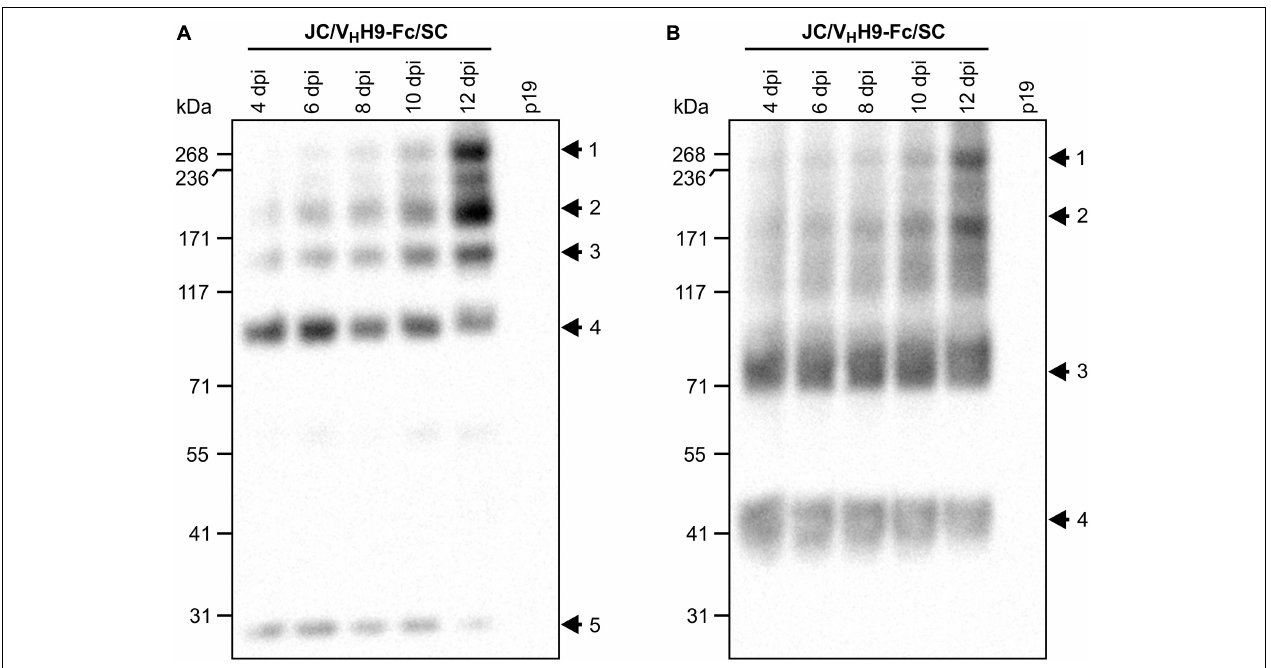
FIGURE 4 | V H H9-sIgA subunits assemble in vivo over time. N. benthamiana leaves were co-infiltrated with a mixture of the indicated Agrobacterium strains, and leaf samples were collected from 4 to 12 dpi. Extracts were prepared under native conditions and separated with SDS-PAGE under non-reducing conditions. Extract from p19-infiltrated N. benthamiana leaves at 12 dpi was used as negative control. Equal amounts (10 µ g) of TSP were loaded per lane. Western blot was detected with anti-HA (A) and anti-c-Myc antibodies (B)